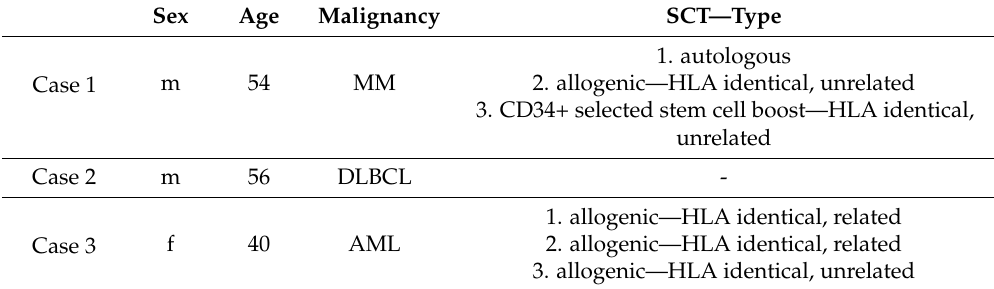
Table 1. Patients’